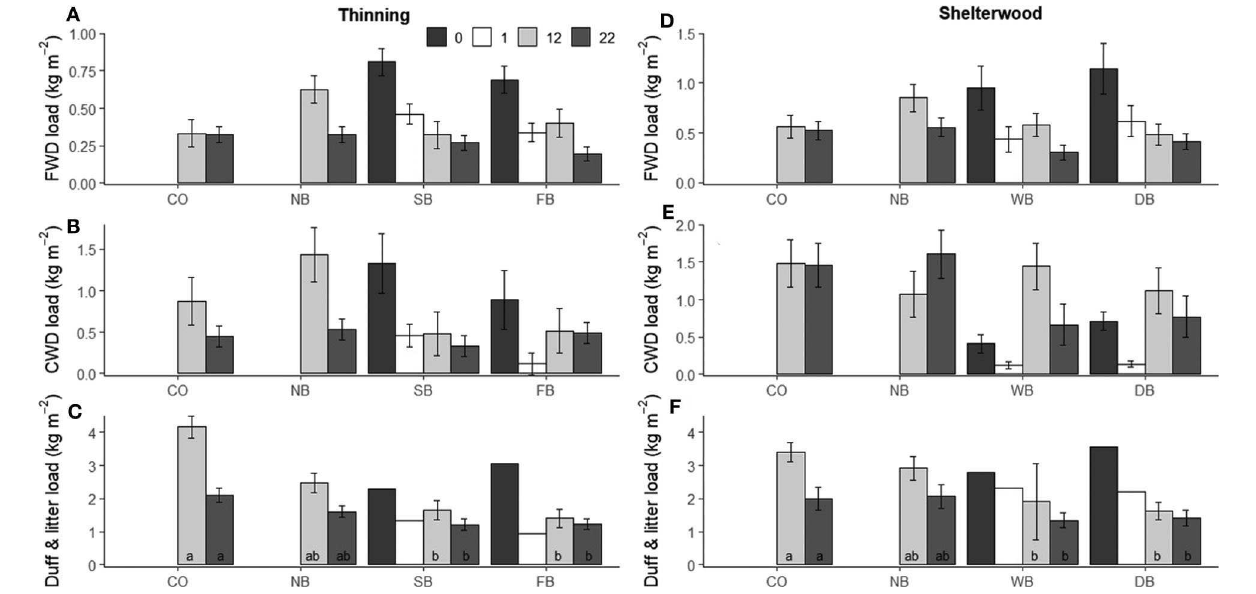
FIGURE 7 | Surface fuel loads (mean and standard error) by treatment and sampling period for (A–C) Thinning and (D–F) Retention Shelterwood. 0 = postharvest and pre-burn; 1 = 1 year post-burn (1993/94); 12 = 12 years post-treatment (2005); 22 = 22 years post-treatment (2015). Treatments: CO = Control, NB = Cut, No Burn, SB = Cut + Spring Burn, FB = Cut + Fall Burn, WB = Cut + Wet Burn, and DB = Cut + Dry Burn. FWD = Fine woody debris ( < 7.62cm diameter); CWD = Coarse woody debris ( ≥ 7.62cm diameter). Fuels not measured in CO and NB treatments at time steps 0 and 1. Duff and litter loads at time step 0 and 1 are from Smith and Arno (1999) with no standard errors available. Lowercase letters denote statistical treatments differences in duff and litter load within a sampling period at α = 0.05. FWD and CWD loads were not statistically